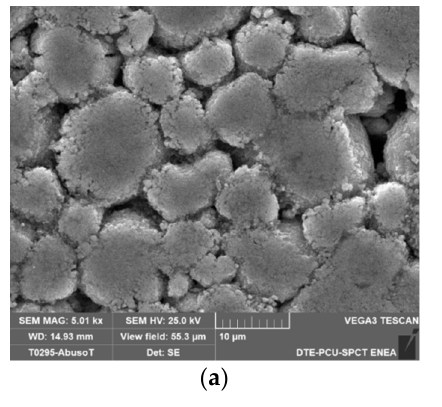
Figure 8. SEM images with a 5000x magnification of the anode of the graphite-based anode cell: ( a ) new, ( b ) overdischarged with a DOD% = 110%, ( c ) overdischarged with a DOD% = 140%.